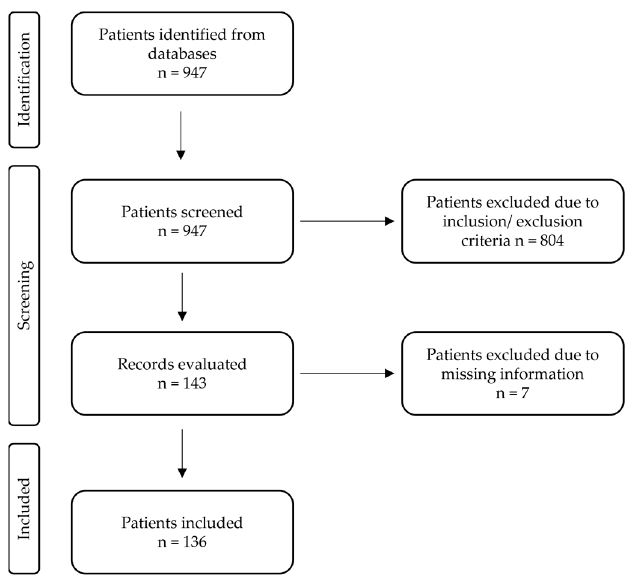
Figure 2. Patient